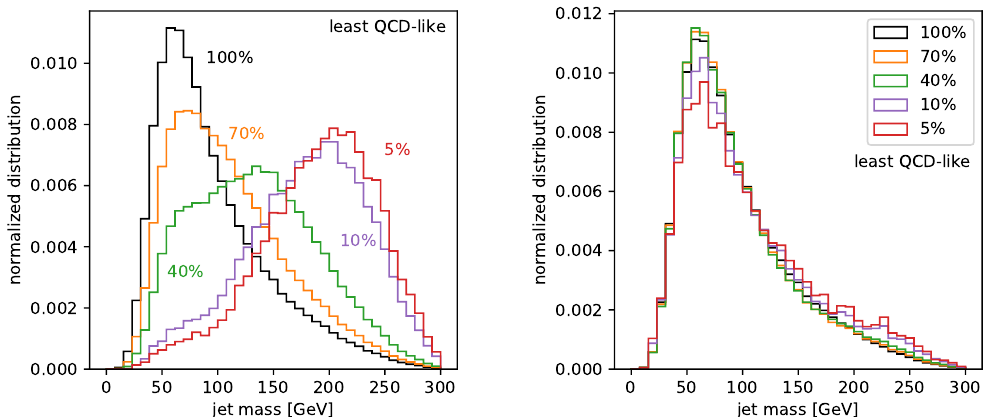
Figure 5: Left: jet mass distributions from the image-based autoencoder applied to QCD jets. The different lines show the full sample up to the 5% least QCD-like jets, defined by the autoencoder loss function. Right: the same jet mass distributions, but for the QCD-trained adversarial autoencoder